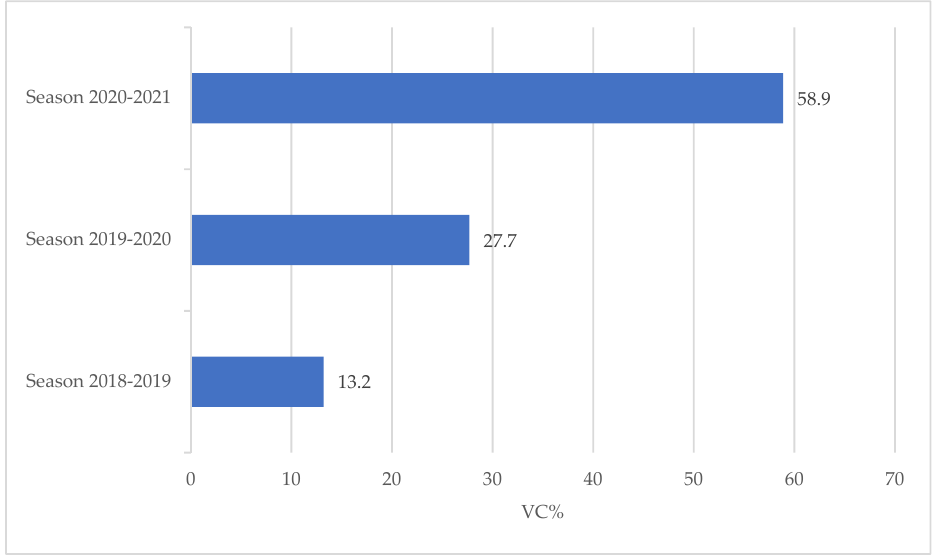
Figure 1. Recorded influenza vaccination coverage (VC%) among AOU-SS healthcare workers in